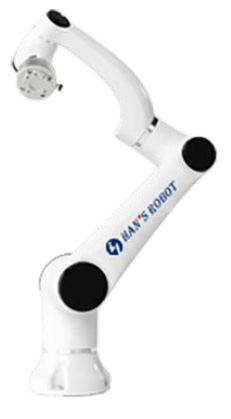
Figure 2. Elfin 10 robot. Table 1. Technical parameters of Elfin 10